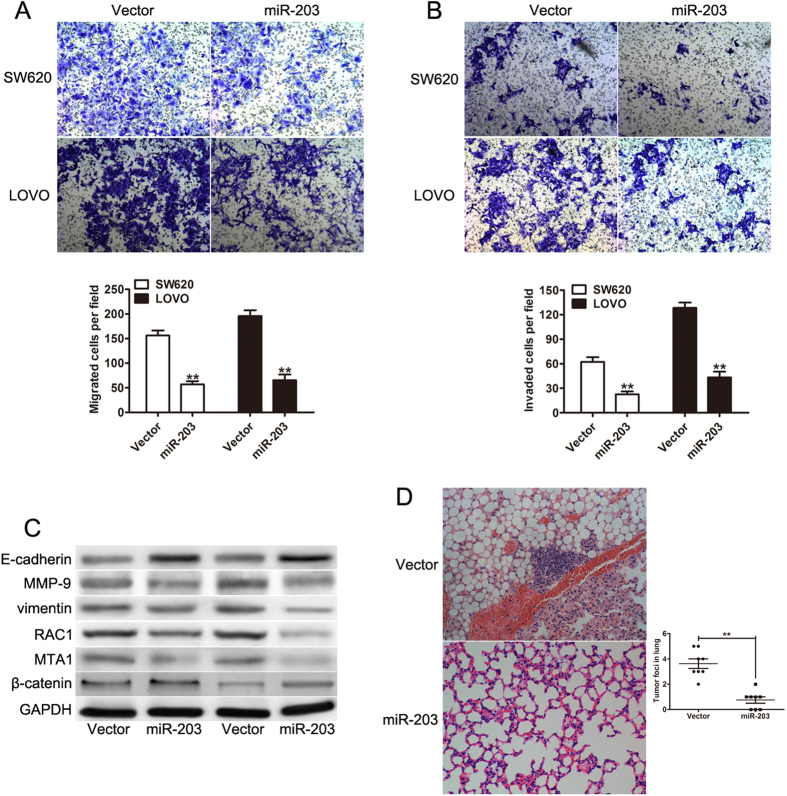
miR-203 suppresses cell migration and invasion in vitro and in vivo.(A) Representative pictures show the migrated SW620 and LOVO cells (left) and quantification of the number of migrated tumor cells (right). (B) Representative pictures of the matrigel invasion assay were obtained for the SW620 and LOVO cells (left), and the number of invasive tumor cells was quantified (right). (C) Western blot analysis of the relative protein levels of MTA1, RAC1, MMP-9, vimentin, β-catenin and E-cadherin in the miR-203 and control groups for both the SW620 and LOVO cell lines. (D) Representative hematoxylin and eosin staining of the lungs isolated from mice injected with the LOVO-vector or LOVO-miR-203 cells. The number of metastatic nodules in the lung was counted in 8 randomly selected high-power fields under a microscope. **p < 0.01.